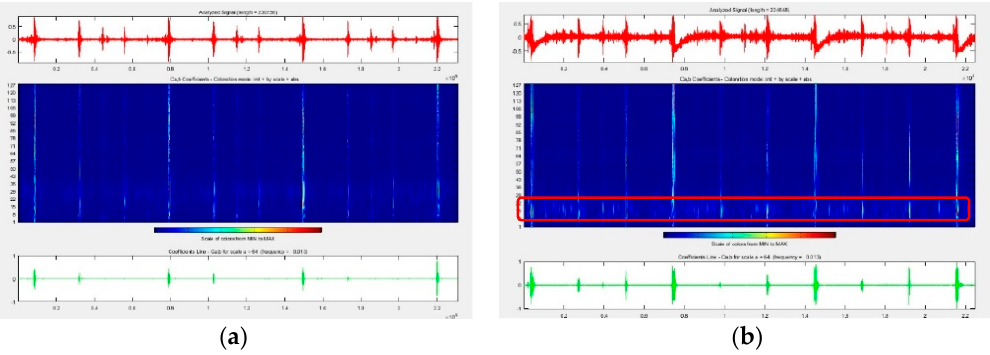
Figure 18. Wavelet decomposition of the acoustic emission signal emitted by a new valve ( a ) and a valve with a leak ( b ).